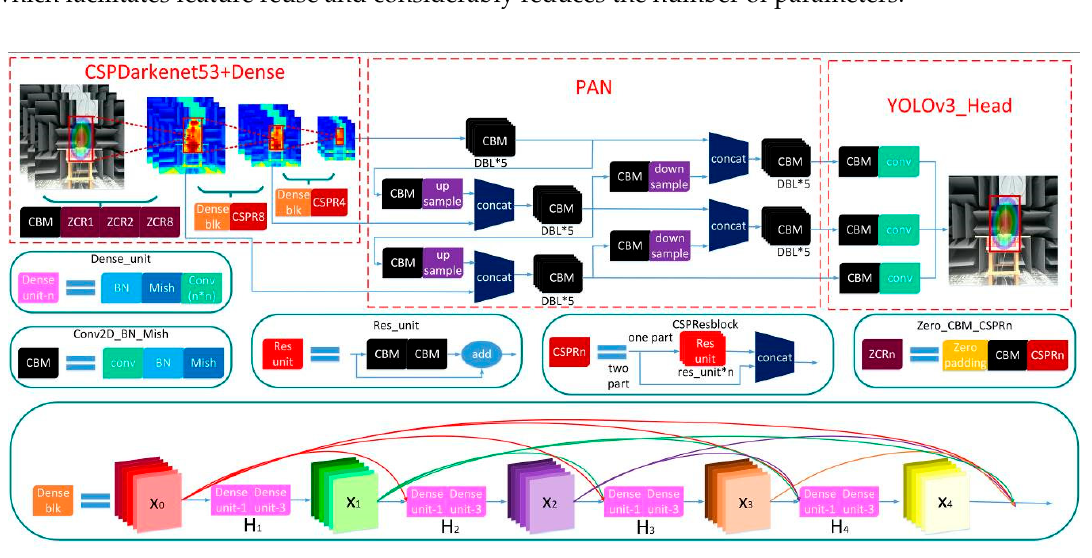
Figure 4. Network structure of improved YOLOv4.